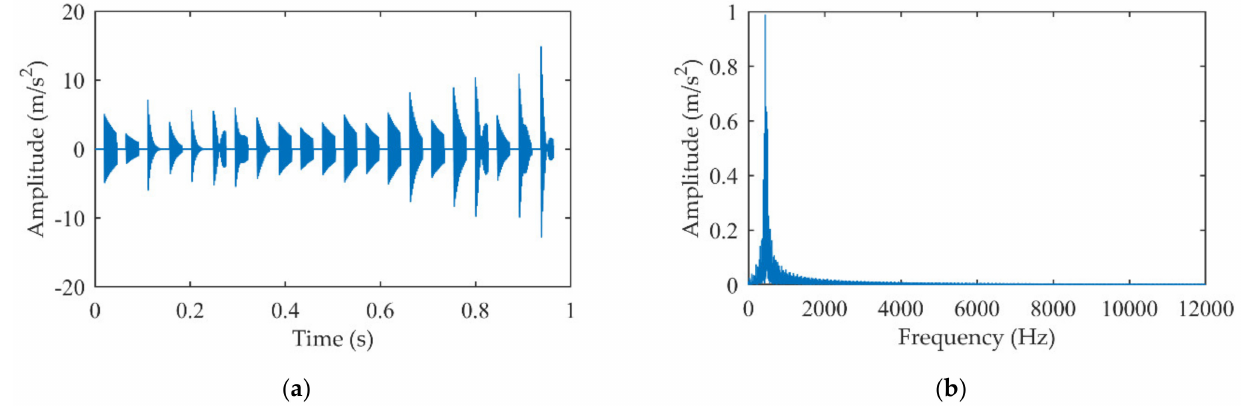
Figure 16. The extracted impact signal by the proposed method: ( a ) Time domain signal; ( b ) Ampli- tude spectrum.